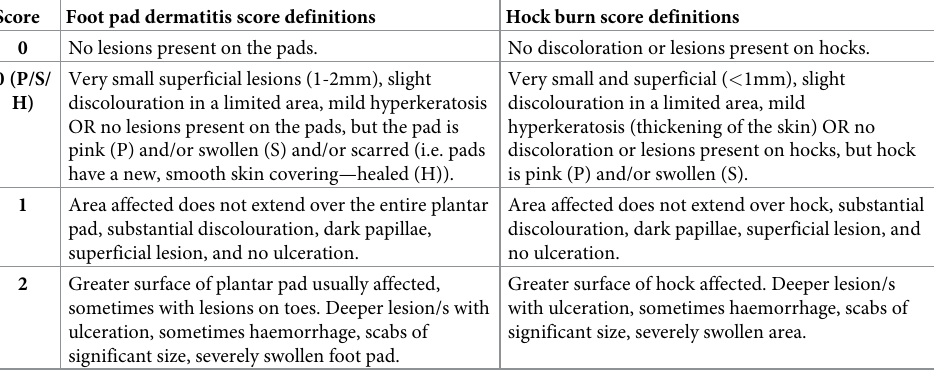
Table 4. Foot pad dermatitis and hock burn scores and definitions a